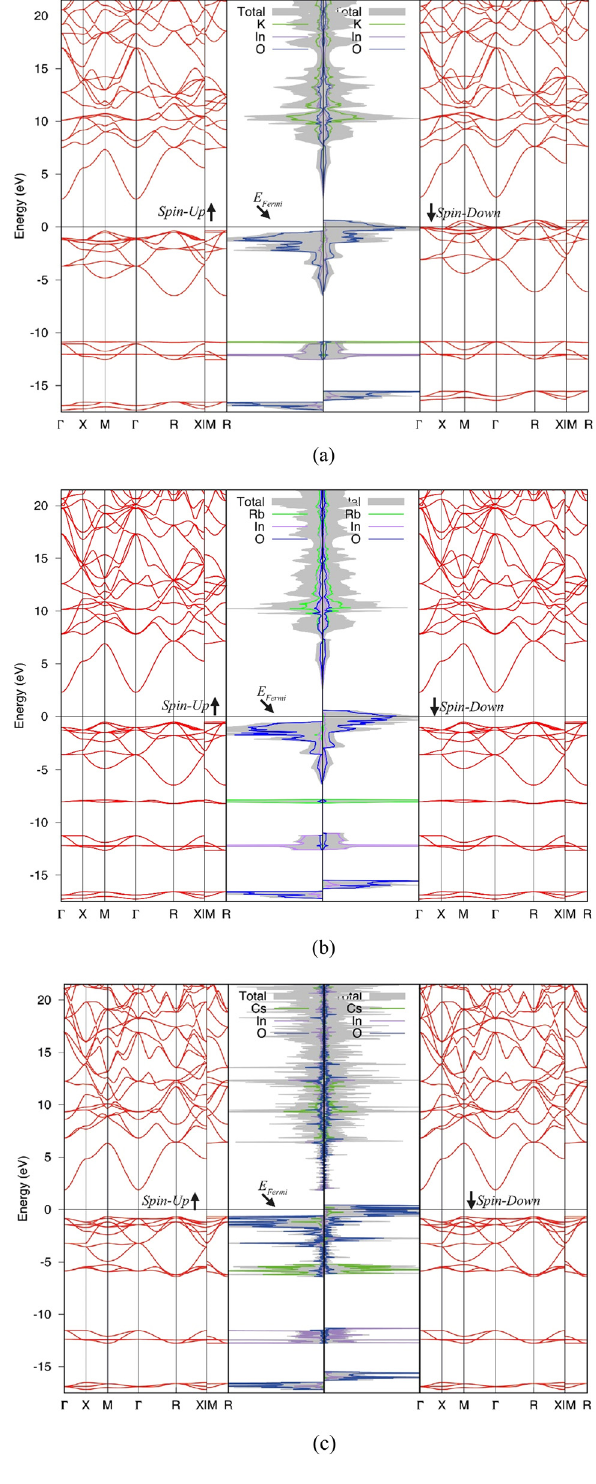
Figure 3: The band structures and related DOSs for XInO 3 ( X = K ( a ) , Rb ( b ) , and Cs ( c ))